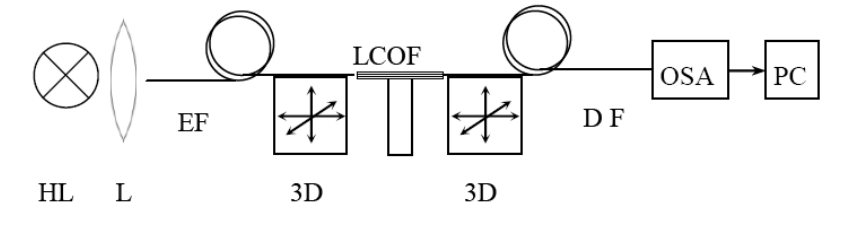
Figure 1. Experimental configuration for local spectral analysis of LCOF—liquid core